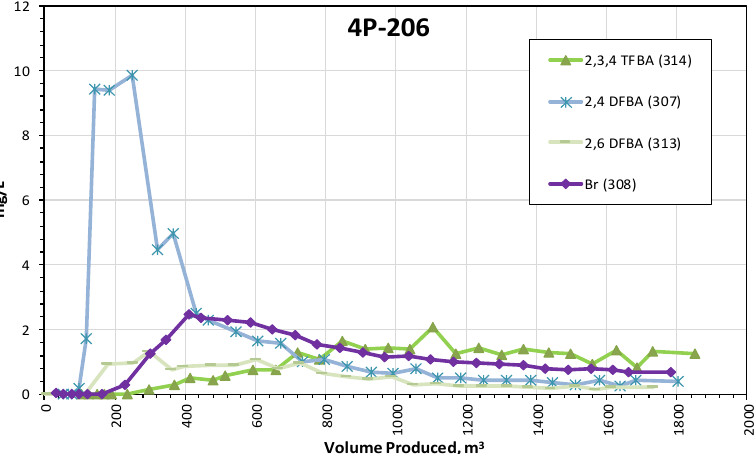
Figure A6. Tracer breakthrough curves as a function of volume produced in well 4P-206. Legend indicates number of the well into which each tracer was injected.